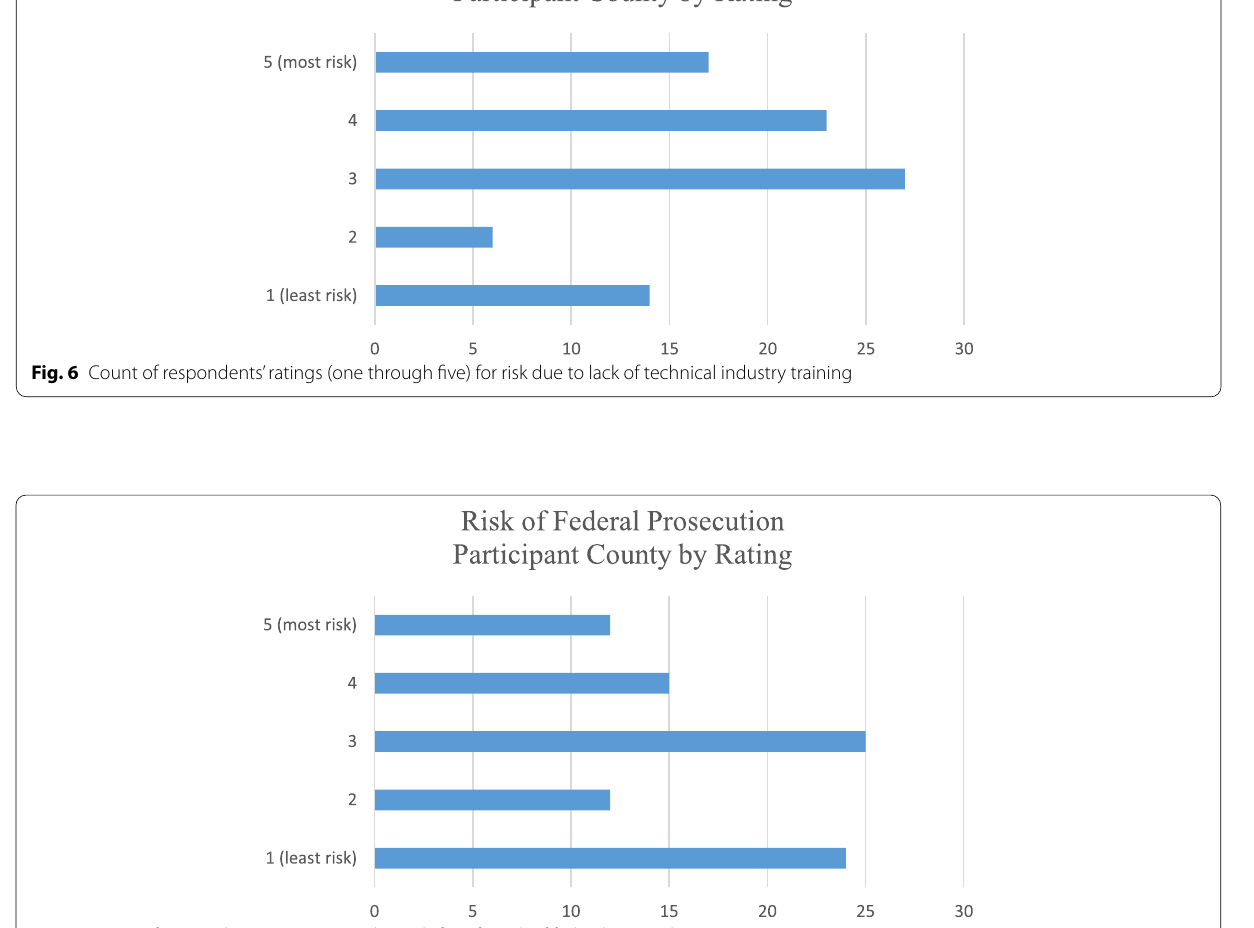
Fig. 7 Count of respondents’ ratings (one through five) for risk of federal criminal